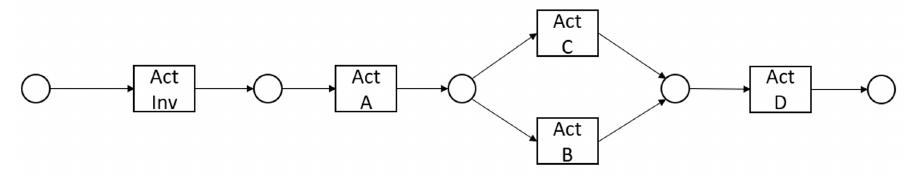
Figure 1. Example of a Petri Net